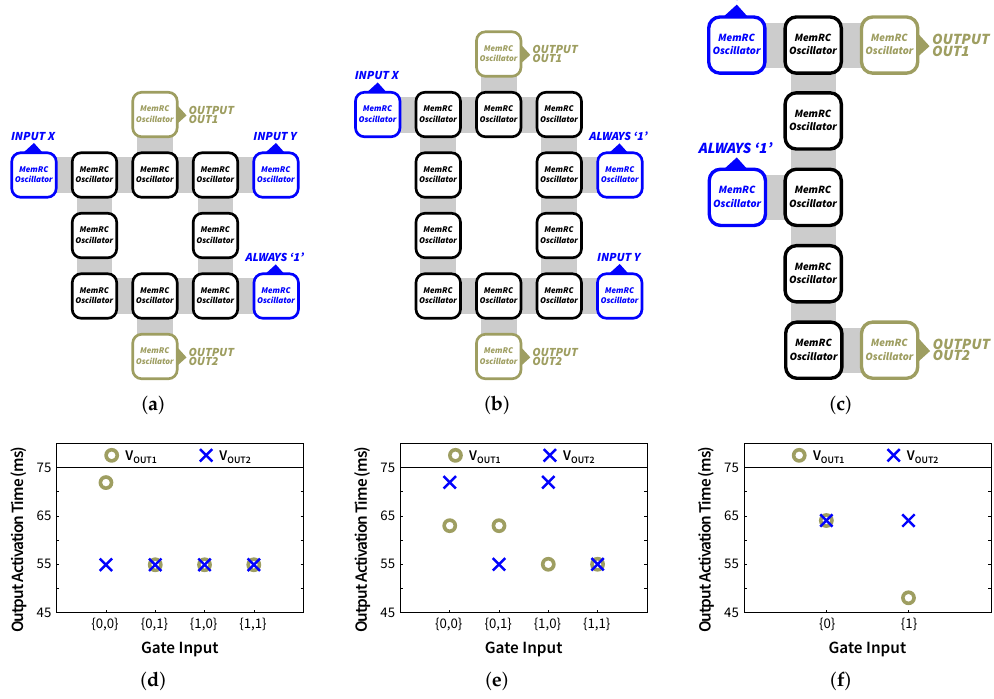
Figure 21. Schematics for the examples of ( a ) OR , ( b ) AND and ( c ) NOT logic gates. Activation time